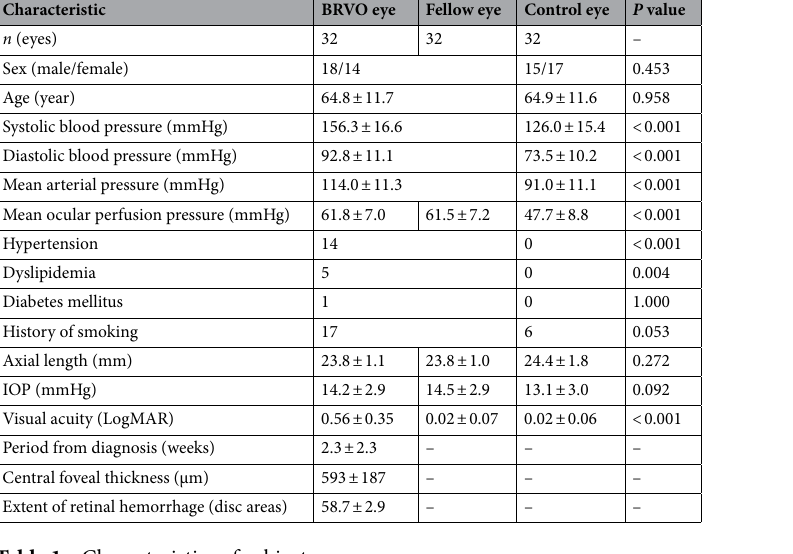
Table 1. Characteristics of